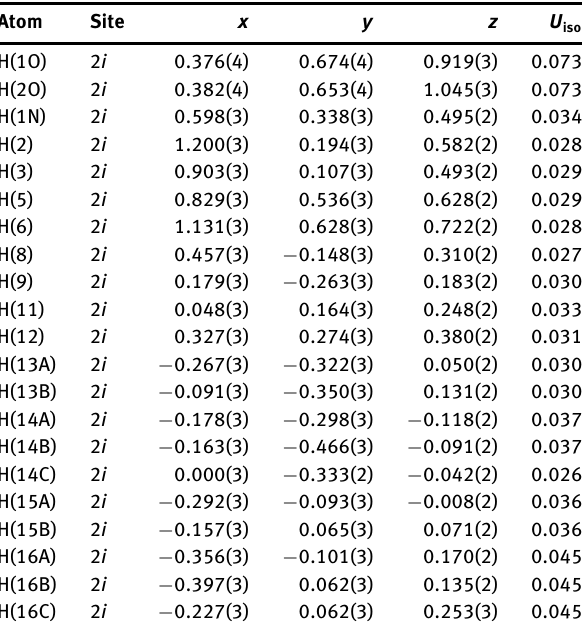
Table 2: Fractional atomic coordinates and isotropic or equivalent isotropic displacement parameters (Å 2